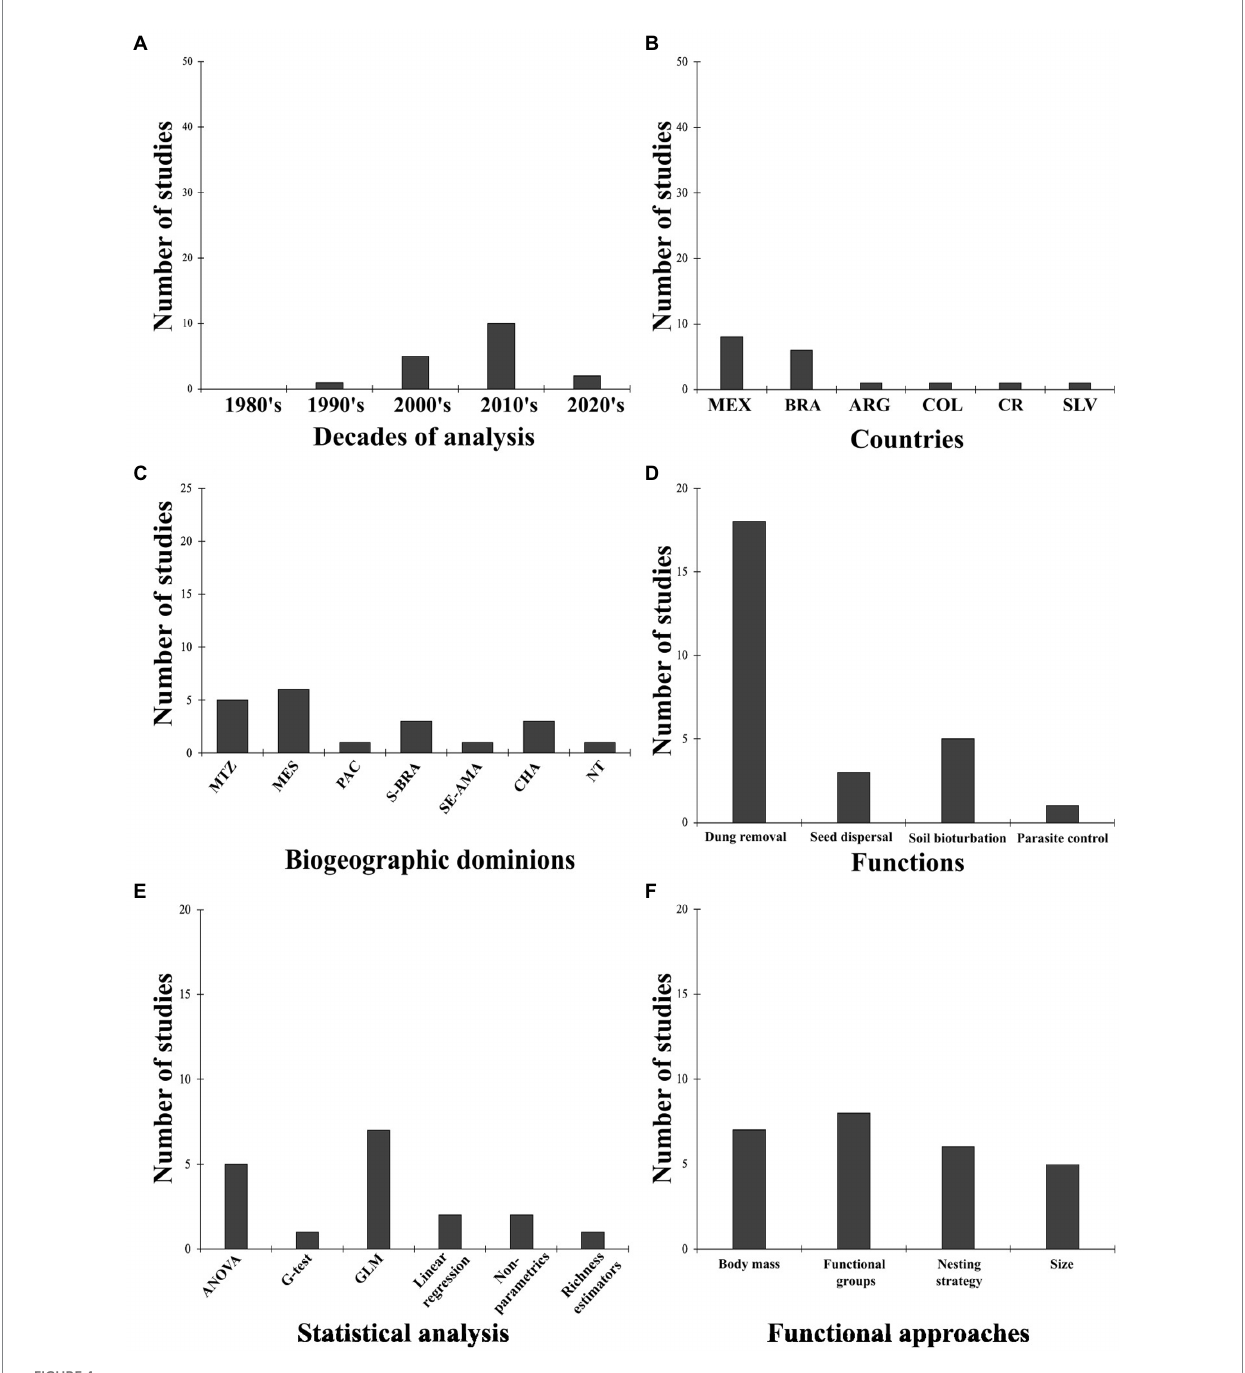
FIGURE 4 Number of ecological functions studies. (A) Over time (decades). (B) Per country. Brazil = BRA, Mexico = MEX, Colombia = COL, Costa Rica = CR, El Salvador = SLV, Argentina = ARG. (C) Per biogeographic dominion. Mexican Tranzition Zone = MTZ, Mesoamerican = MES, Pacific = PAC, Boreal Brazilian = B-BRA, SATZ = South American Transition Zone, South Eastern Amazonian = SE-AMA, Chacoan = CHA, Parana = PAR, Not tropical = NT. (D) Per function. (E) Per statistical analysis. (F) Per functional